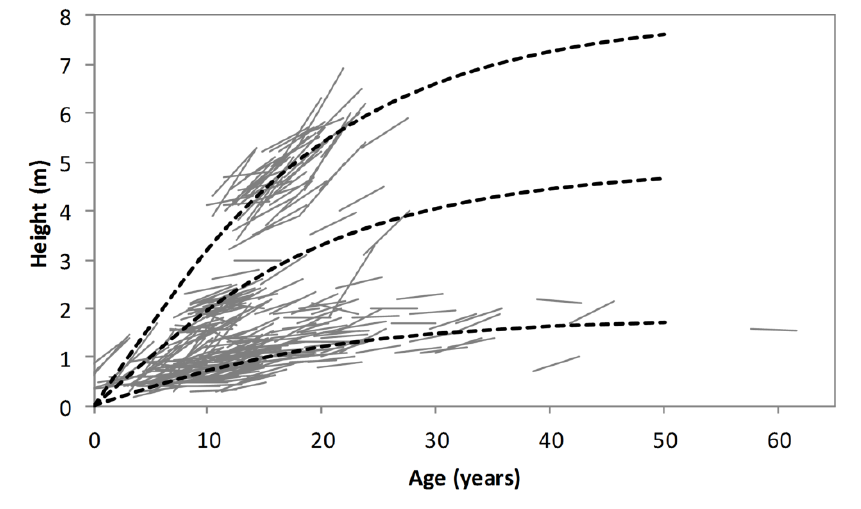
Figure 6. Illustration of the procedure used for backcasting height. The dashed lines show the family of height/age functions described by Equation (4) for low, medium and fast growing shrubs. The solid lines show 2008–2012 heights of measured stems, with ages estimated using Equation (3).